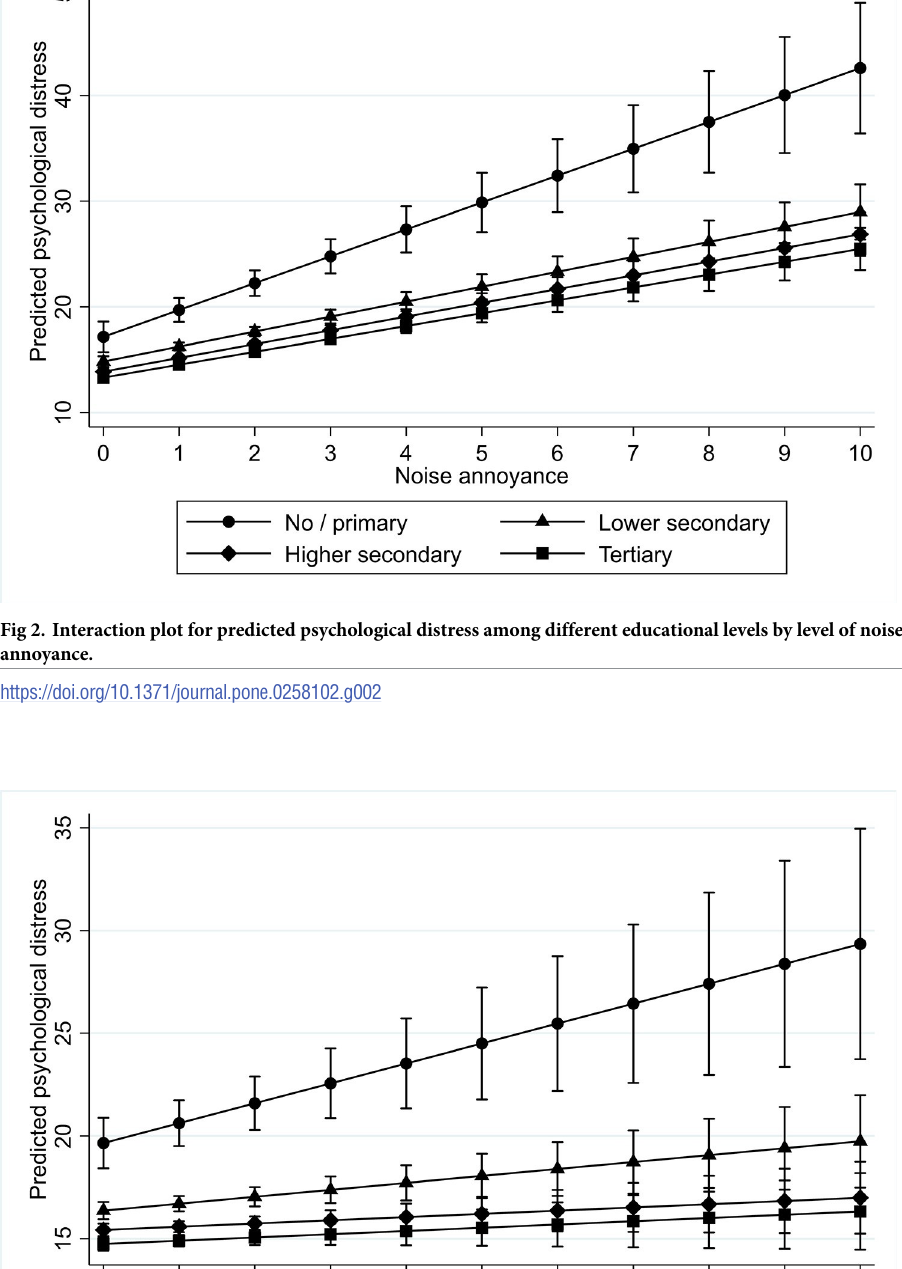
PLOS ONE | https://doi.org/10.1371/journal.pone.0258102 October 1,